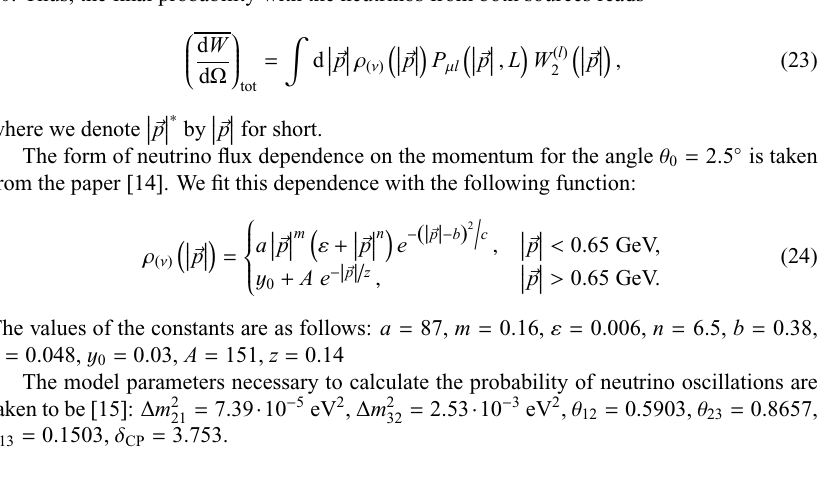
The values of the constants are as follows: a = 87, m = 0 . 16, ε = 0 . 006, n = 6 . 5, b = 0 . 38, c = 0 . 048, y 0 = 0 . 03, A = 151, z = 0 . 14 The model parameters necessary to calculate the probability of neutrino oscillations are = 7 . 39 = 2 . 53 10 − 5 eV 2 , ∆ m 2 10 − 3 eV 2 , θ 12 = 0 . 5903, θ 23 = 0 . 8657, taken to be [15]: ∆ m 2 32 21 · · θ 13 = 0 . 1503, δ CP = 3 .